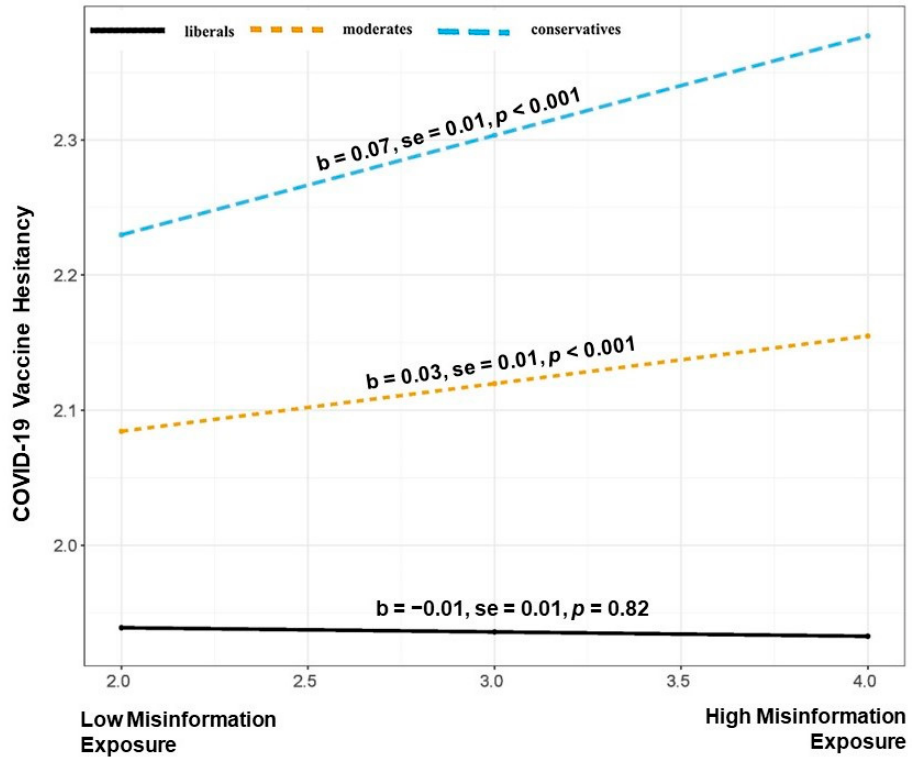
Figure 1. Illustration of the interaction between perceived misinformation exposure and political ideology in predicting COVID-19 vaccine